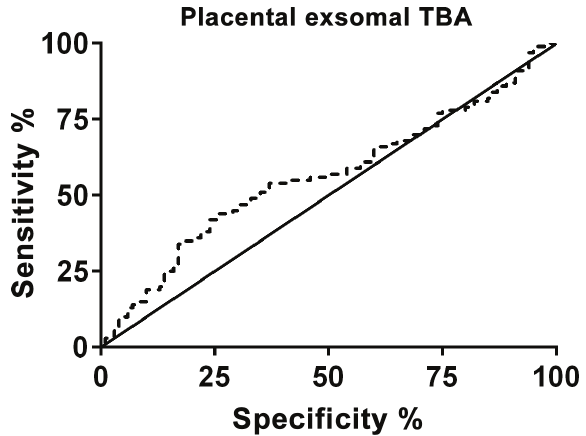
Fig. 1. Diagnostic values of placental exosomal levels of TBA in healthy pregnant participants and ICP patients were analysed by receiver operating characteristic curves. TBA, total bile acid; ICP, intrahepatic cholestasis of pregnancy.